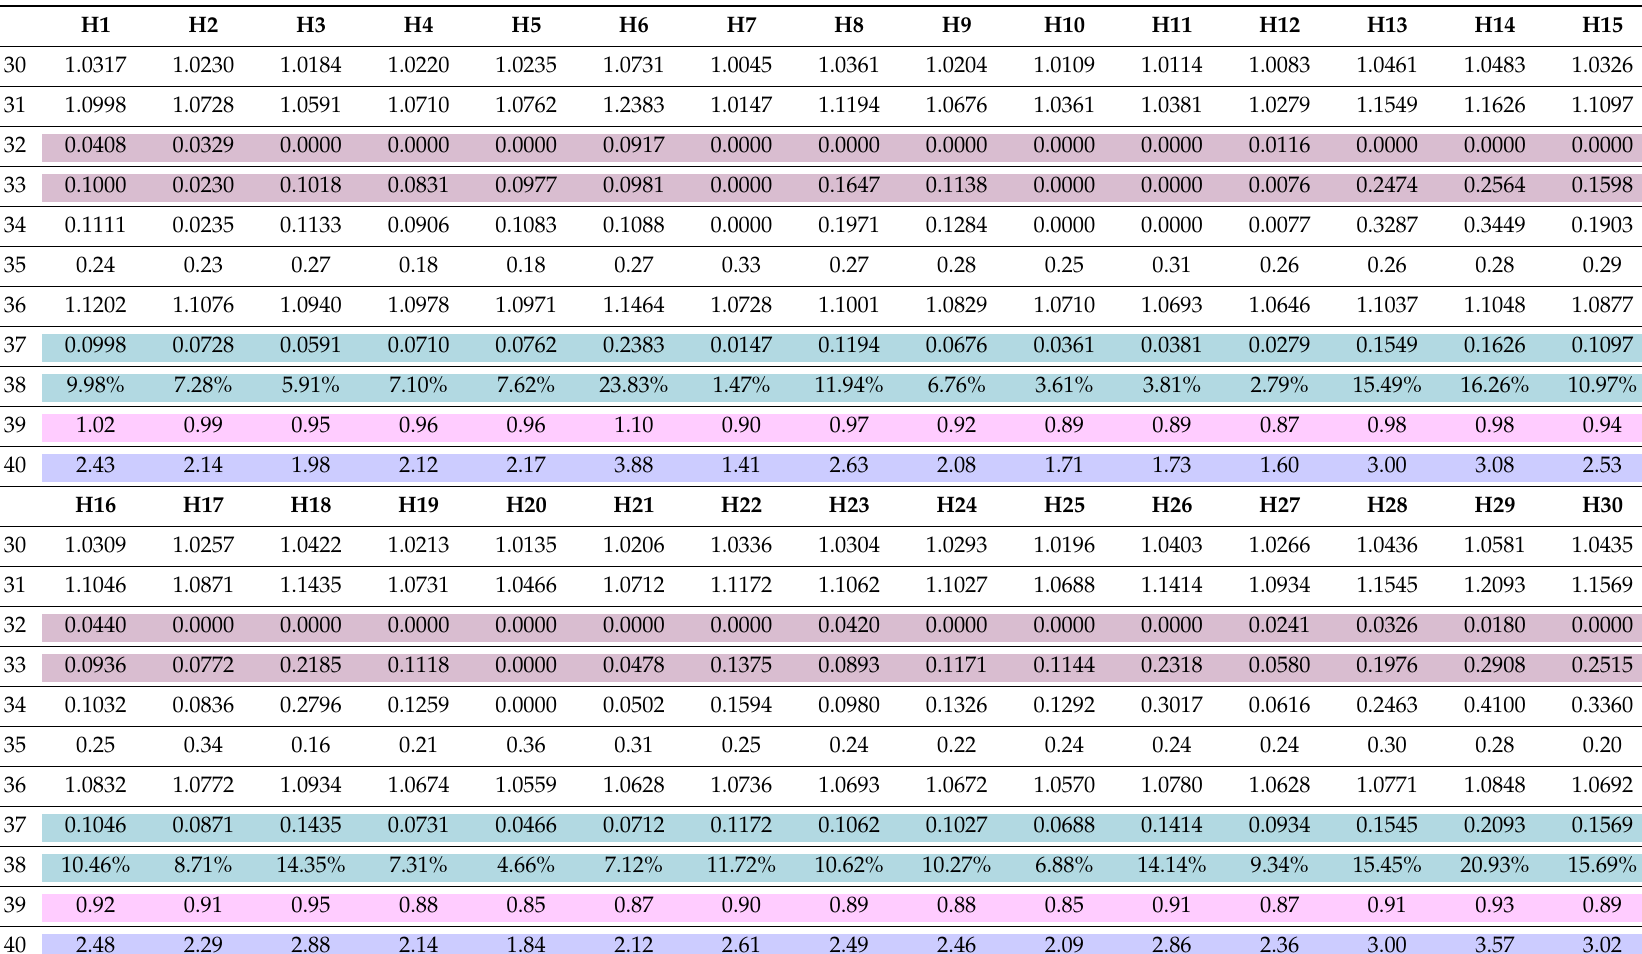
Table A3. The calculated values of the indicators of the H1–H30 building set: (30) RC cd ; (31) RC sq ; (32) RDP ; (33) RDA ; (34) RDA’ ; (35) WWR ; (36) A / V ; (37) JC ( = W / F